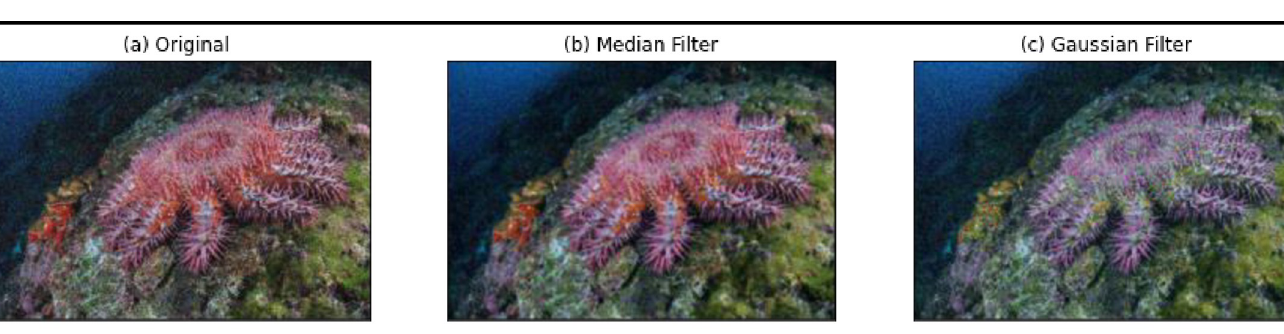
Fig 7. (a) Original Image (b) Image after the application of Median Filter (c) Image after the application of Gaussian filter.